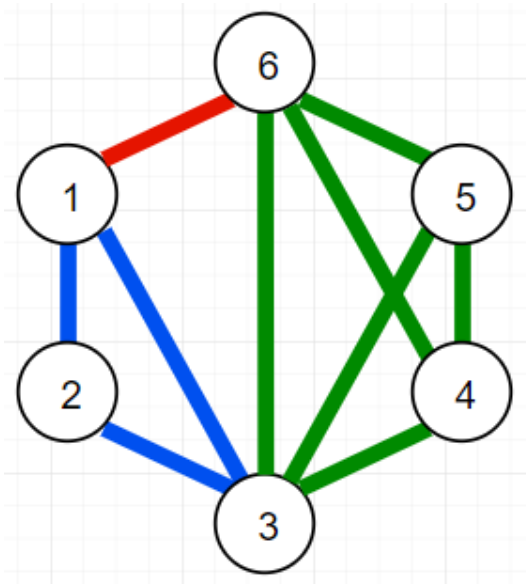
Figure 5. Example of a graph with 3